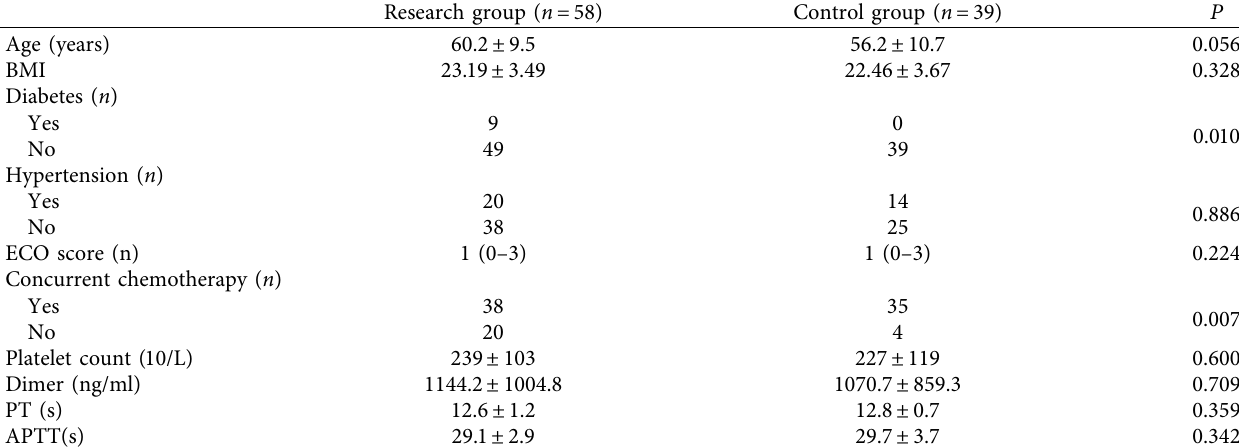
Table 1: Basic information of patients.